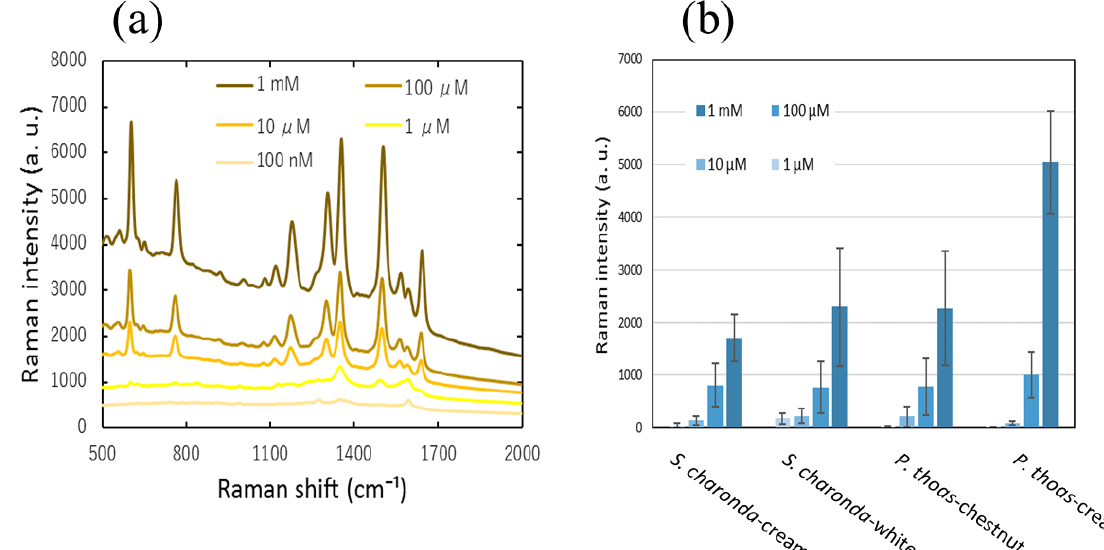
Figure A5. Dependence of the R6G SERS spectra on the R6G concentration for various scales of S. charonda and P. thoas. ( a ) SERS spectra of 1 mM, 100 µM, 10 µM, 1 µM and 100 nM R6G from cream scales of S. charonda with 100 nm silver deposition. ( b ) A bar graph summarizing intensities of the 774 cm − 1 band from cream and white scales of S. charonda, and chestnut and cream scales of P. thoas obtained from the spectra in Figure A6.